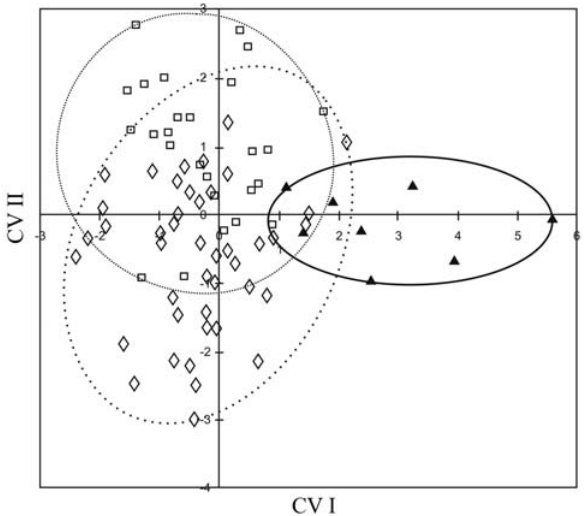
Figure 2 - Projection of the individual scores obtained in a size-free ca- nonical discriminant analysis of 23 morphological body features of the combinedsamplesof Leporinuselongatus oftheMogi-GuaçúandParana- panema populations. The diamonds ( ◊ ) correspond to cytotype C 1 C 1 , squares ( ❐ ) to cytotype C 1 C 2 and the dark triangles ( (cid:2) ), to C 2 C 2 .